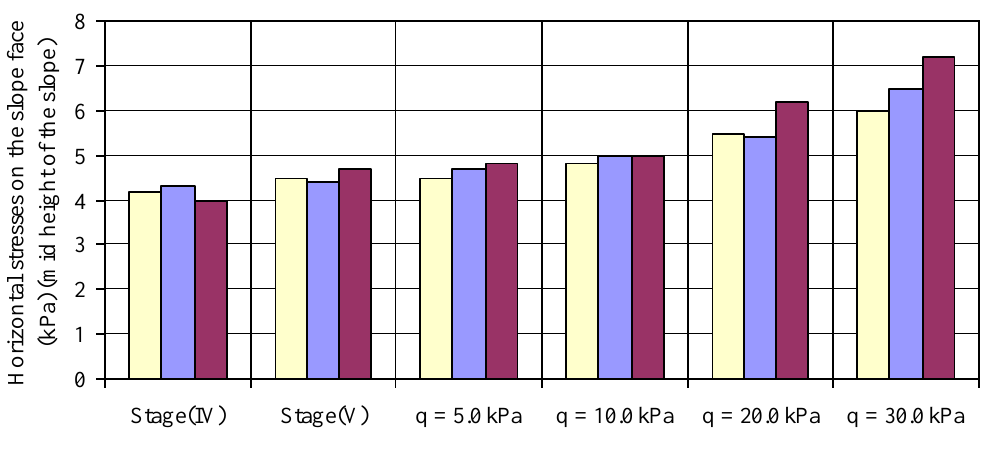
Figure 9. Influence of soil density on the slope face horizontal stresses at